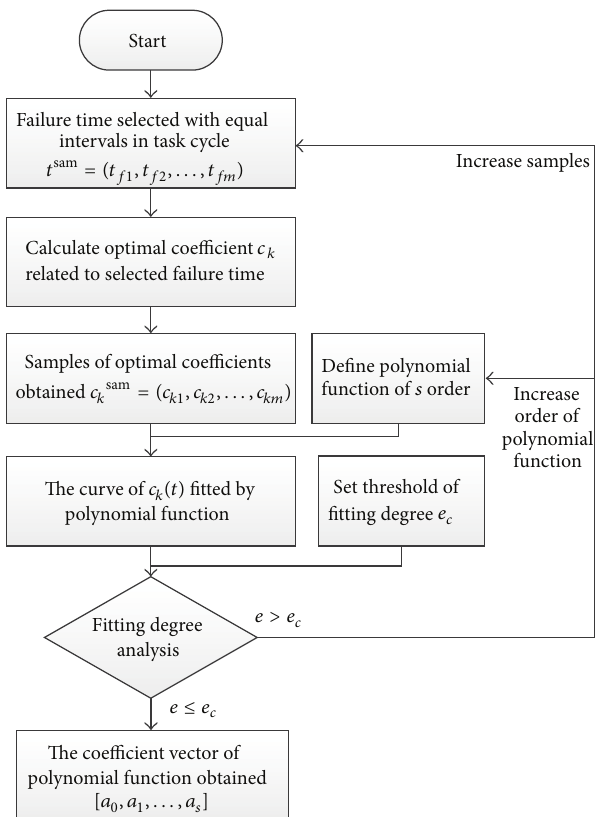
Figure 3: Calculation process of function c 𝑘 (𝑡)